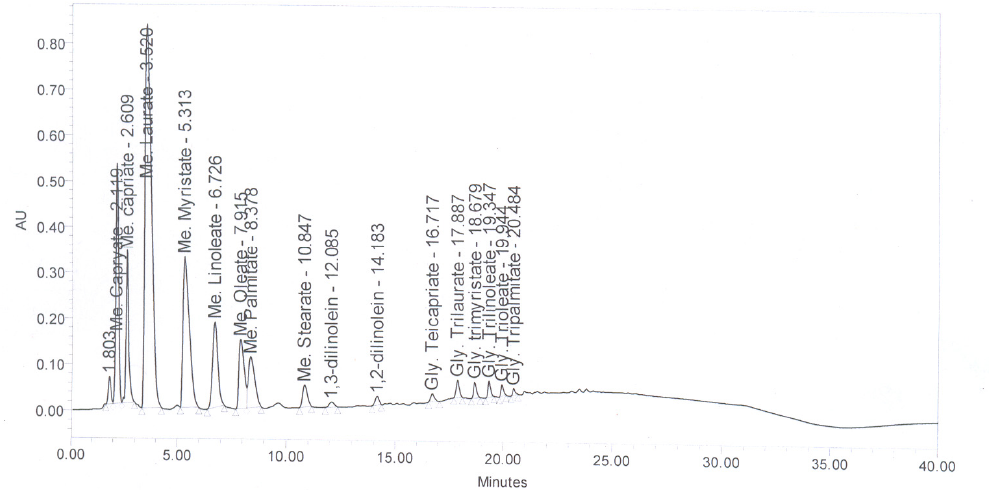
Figure 9. HPLC Chromatogram of coconut oil biodiesel in separating funnel second.